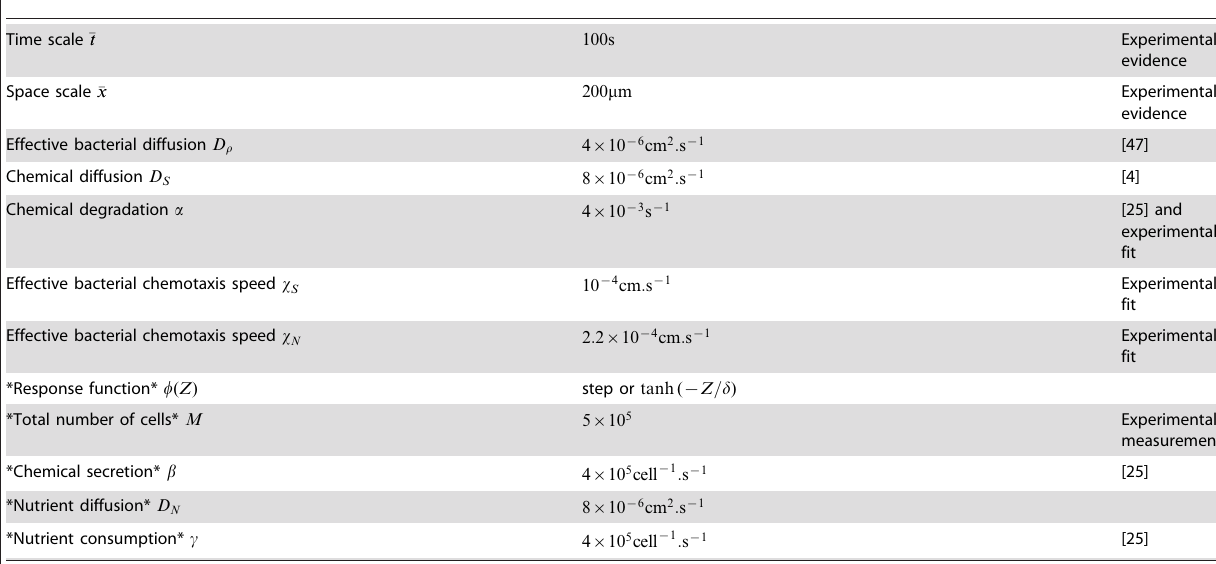
Table 1. Set of parameters.